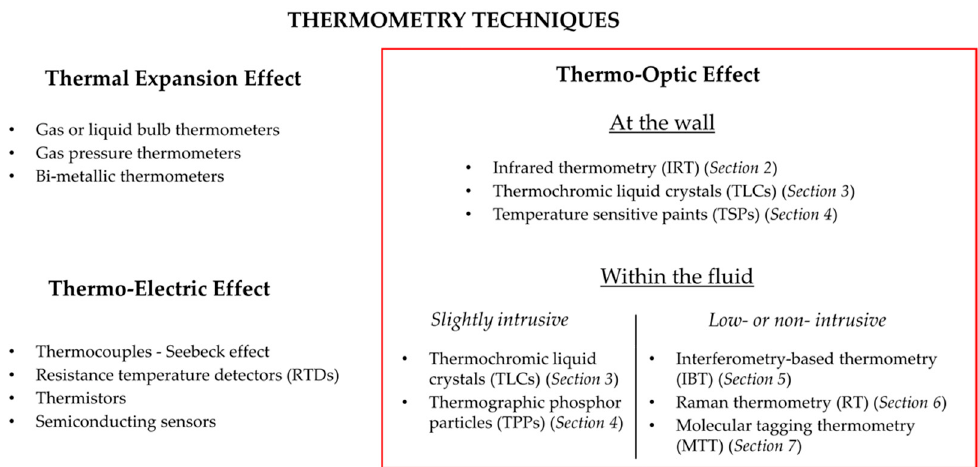
Figure 3. Classification of various temperature measurement techniques according to the underlying physical principle exploited.